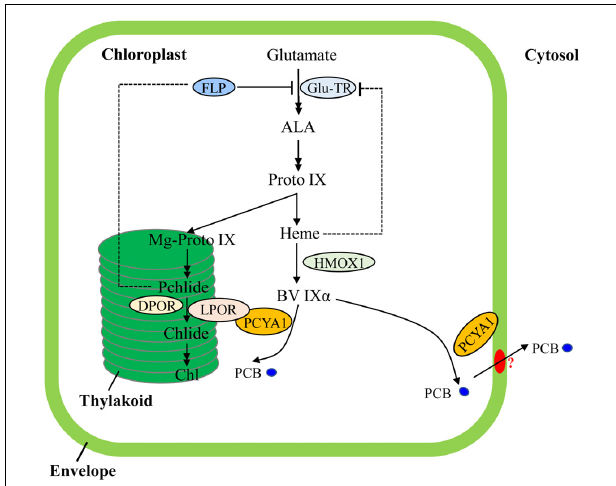
FIGURE 7 | Schematic illustration of tetrapyrrole pathway and regulatory mechanisms of tetrapyrrole biosynthesis in C. reinhardtii . FLP is a negative regulator of Glu-TR activity. Heme may also feedback inhibit Glu-TR activity, but to a lesser extent. PCYA1 is likely involved in regulation of Chl biosynthesis by direct interaction with LPOR. Additionally, the PCB molecule is exported from chloroplast to cytosol, via yet-to-be identified bilin transporter (red oval). ALA, 5-Aminolevulinic acid; Proto IX, protoporphyrin IX; Mg-Proto IX, magnesium-protoporphyrin IX; Pchlide, protochlorophyllide; Chlide, chlorophyllide; Chl, chlorophyll; BV IX α , biliverdin IX α ; PCB, phycocyanobilin; Glu-TR, Glutamyl-tRNA reductase; HMOX1, heme oxygenase 1; PCYA1, phycocyanobilin ferredoxin-dependent biliverdin oxidoreductase; LPOR, light-dependent protochlorophyllide oxidoreductase; DPOR, light-independent protochlorophyllide